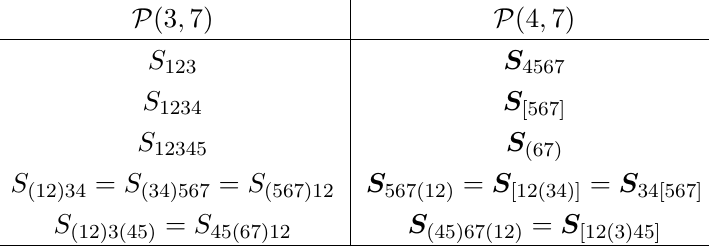
Table 3 . Dictionary between facets in P (3 ; 7) and those in P (4 ;